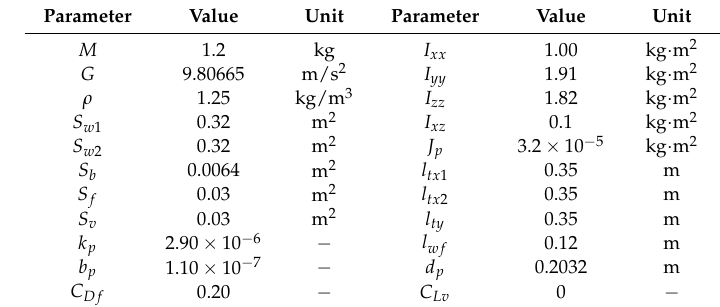
Table 2. Parameters.